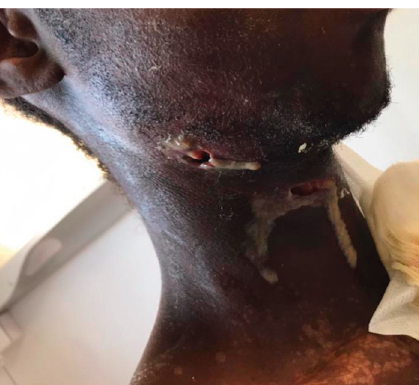
Figure 1: Photograph showing the right jugal swelling with fistulizations under the right maxilla and cervical leaving pus (white